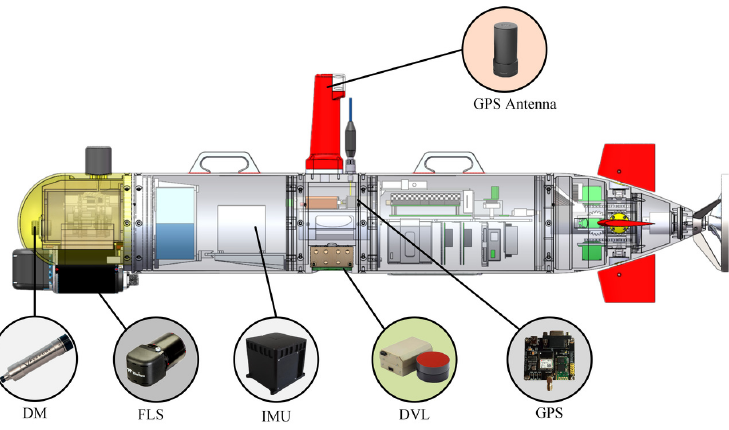
Figure 1. The structure of the experiment platform.